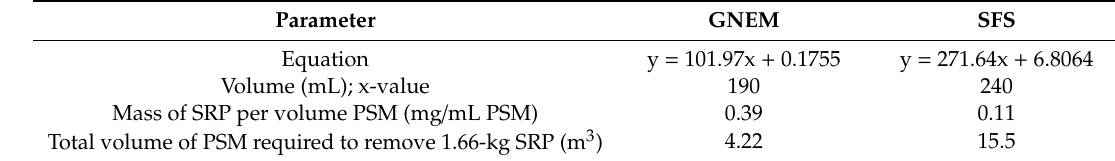
Table 7. Measured GNEM and SFS column characteristics. PSM: phosphorus sorbing media. Parameter